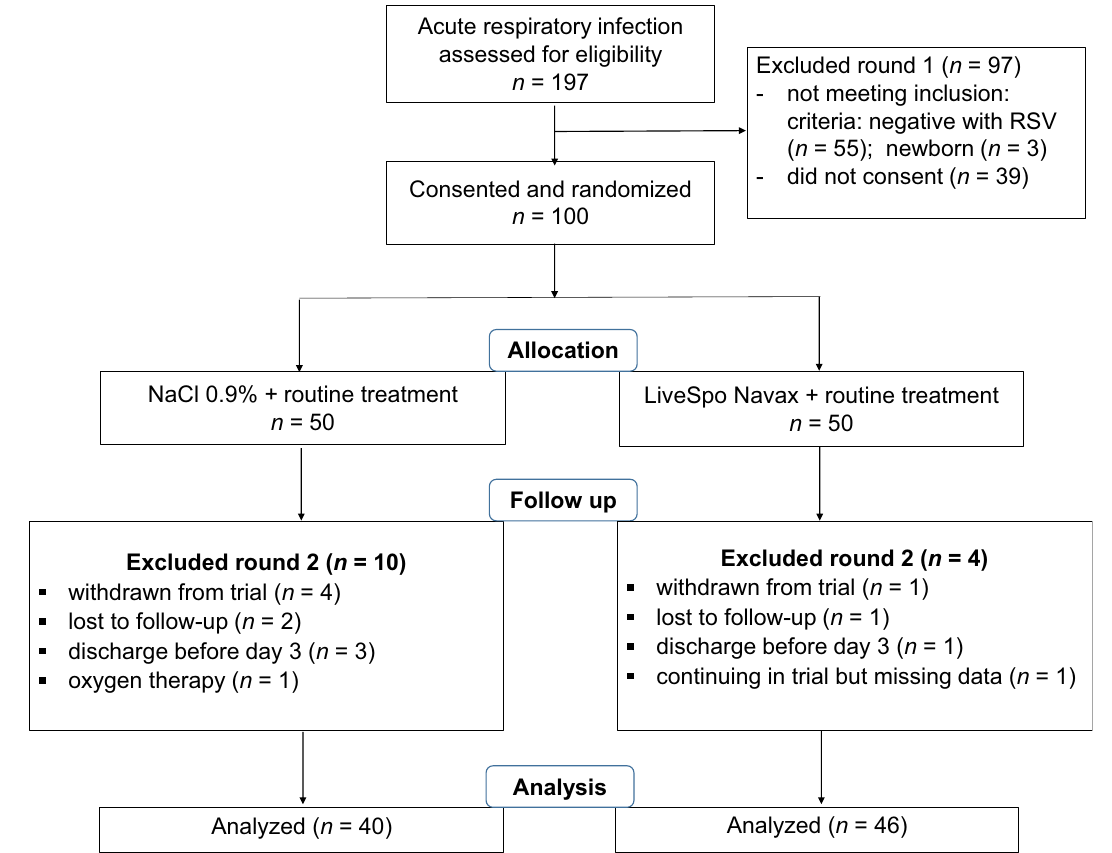
Figure 1. Diagram displaying the flow of participants involved in the study. From the clinical database, participants were screened for eligibility. Eligible participants who provided consent were randomized in either Control or Navax group. Measurements took place between baseline (day 0) and day 6 of treatment period. Participants were recruited from August 2020 to July 2021. Clinical and subclinical data collection and analysis were conducted from September 2020 to August